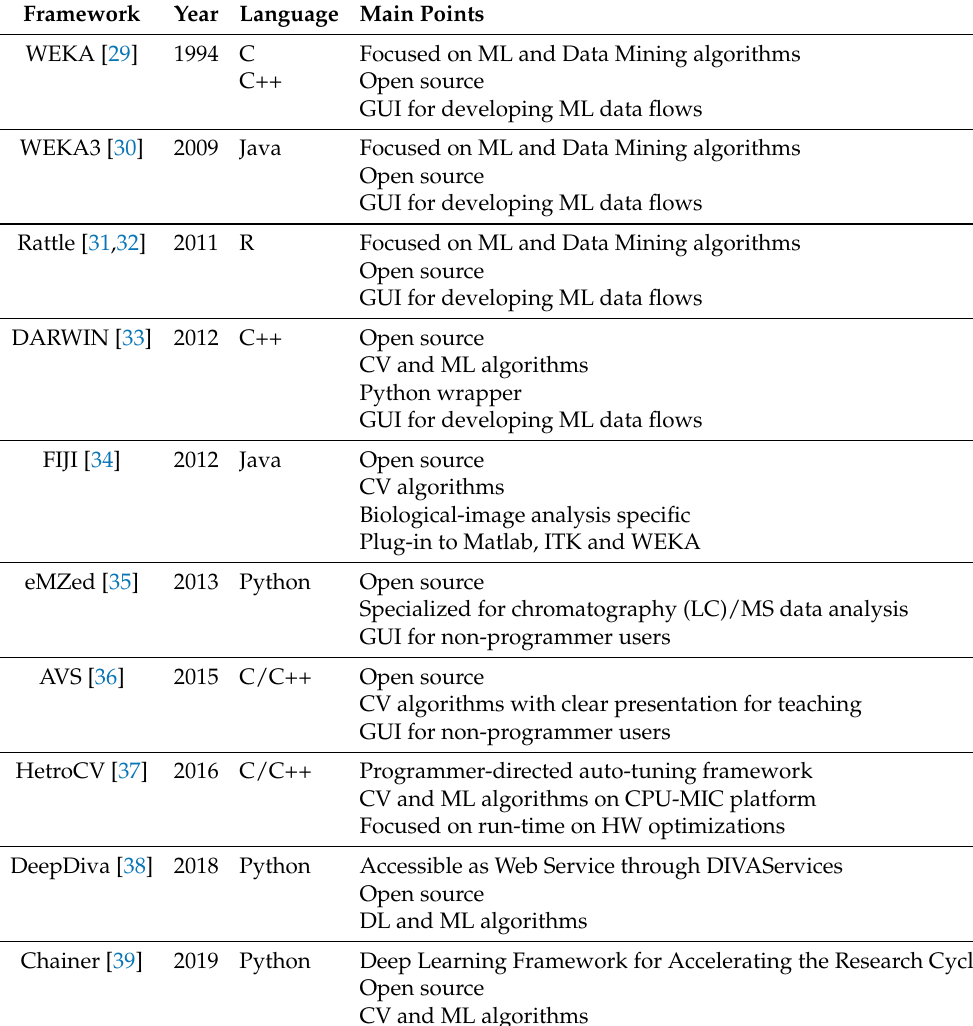
Table 1. Comparison of different CV